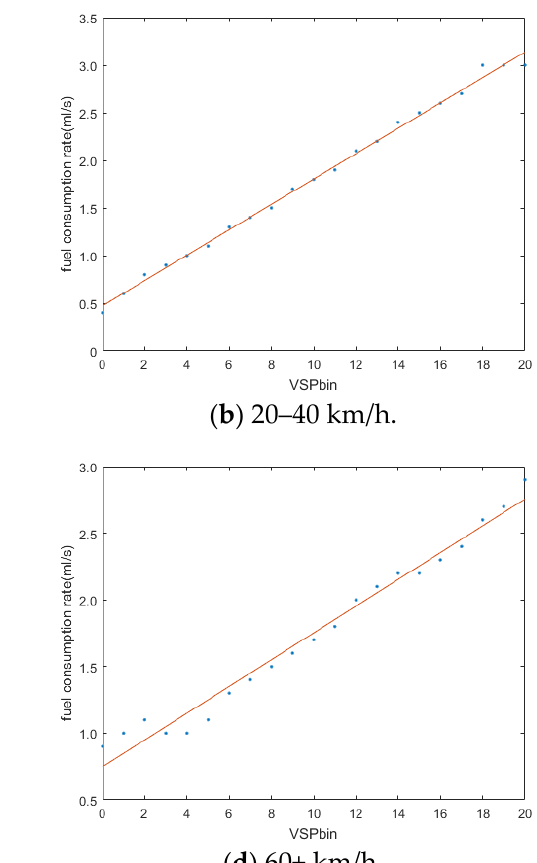
Figure 5. The VSP-fuel consumption scatter plot.